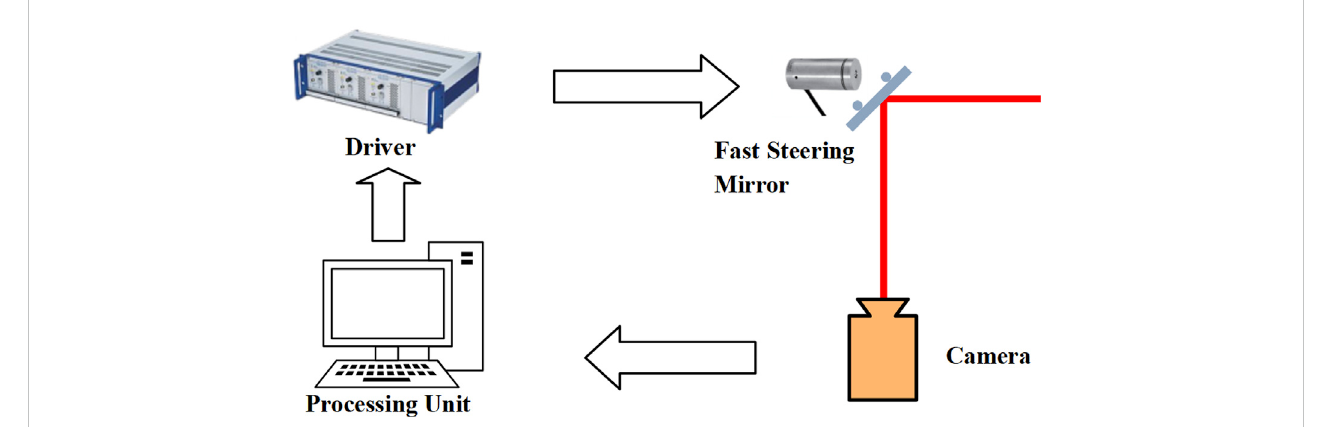
FIGURE 1 High-speed and high-resolution beam stabilization